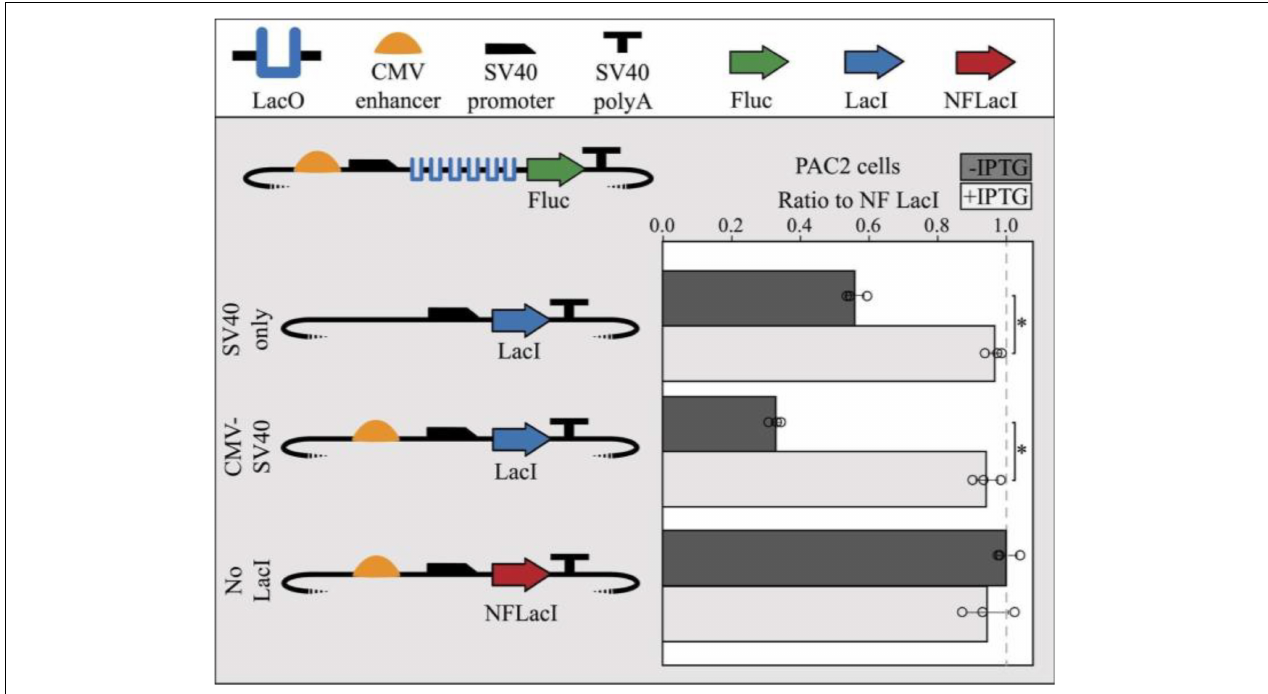
FIGURE 2 | Co-transfection of LacI-expressing modules with repressible reporter modules result in LacI-mediated repression in PAC2 cells. SV40 promoter-only driven expression of LacI shows moderate repression (40%) and CMV enhancer-driven expression of LacI shows high repression (70%) of a repressible module containing 6x LacO sites. Expression of non-functional LacI (NFLacI, frameshift mutant) shows no repression and all modules showed maximal reporter expression in the presence of 1 mm IPTG. Error bars represent standard deviation of replicates ( n = 3). Points represent values for all 3 replicates in each condition. The dashed line shows the NF LacI IPTG- negative control. The TSS starts where the SV40 promoter begins to slope downward. Statistical significance was determined using a Student’s two tailed t -test ∗ P < 0.001.